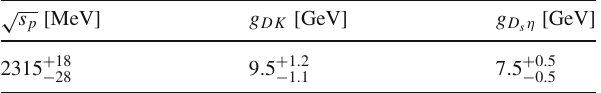
( 2317 ) pole from the unitarized chiral s 0